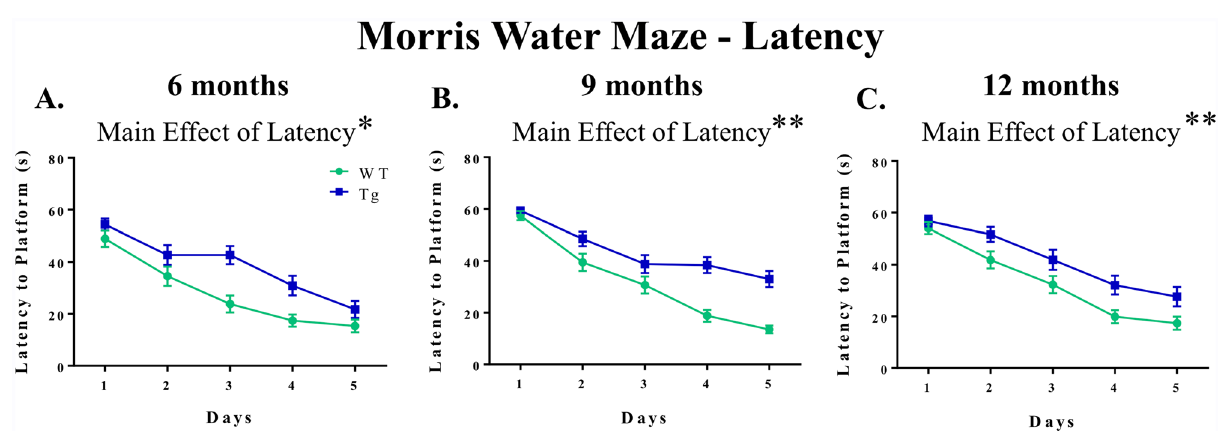
Figure 6. Reference memory performance as evaluated on the MWM: consistent deficits in TgF344-AD rats across each age for latency to the platform. ( a – c ) When evaluating latency to the platform (s) for each age-point across Days 1–5, there was a significant effect of Genotype, whereby Tg rats swam longer to locate the hidden platform than WT rats, indicating spatial reference memory impairment. * p < 0.05, ** p <